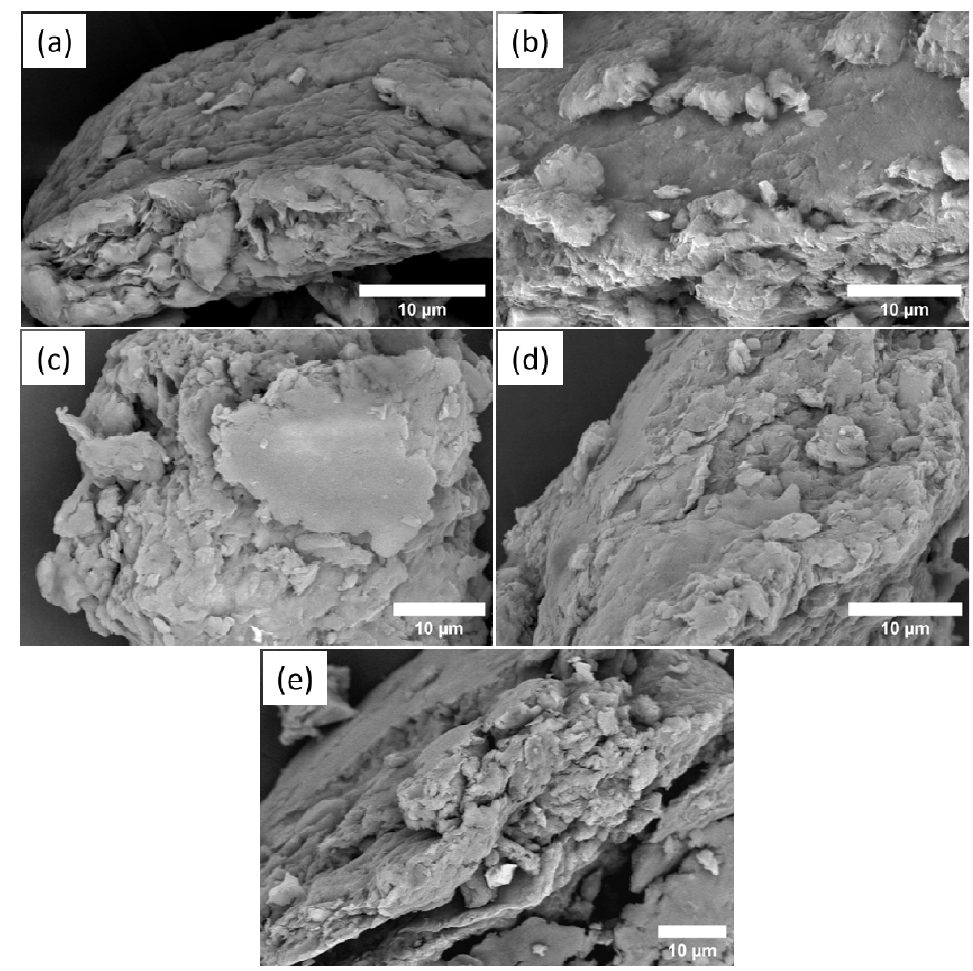
Figure 3. SEM of Bent ( a ), CTAB/Bent ( b ), CTAB/ACN/Bent-4 ( c ), CTAB/ACN/Bent-7 ( d ), and CTAB/ACN/Bent-10 ( e ).